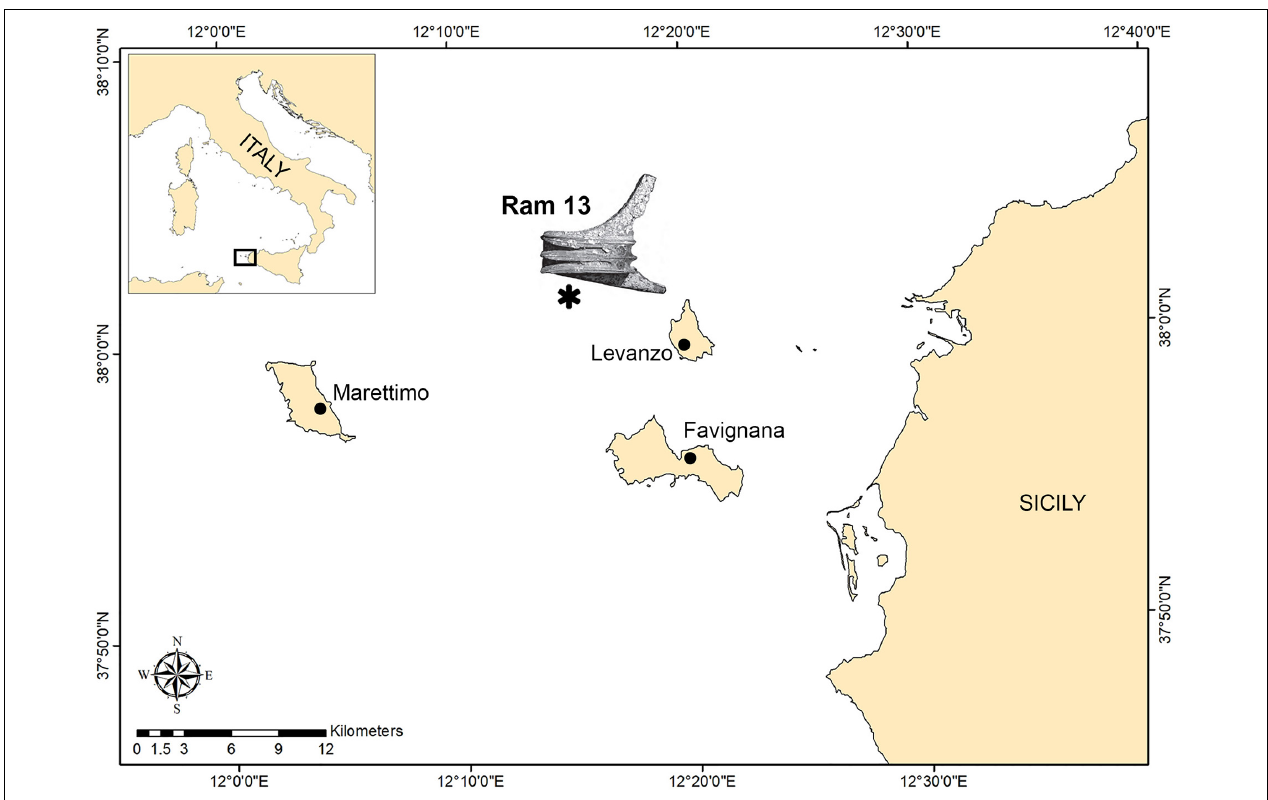
FIGURE 1 | Map of the study area within the Aegadian archipelago. The asterisk indicates the area of ram recovery based on Tusa